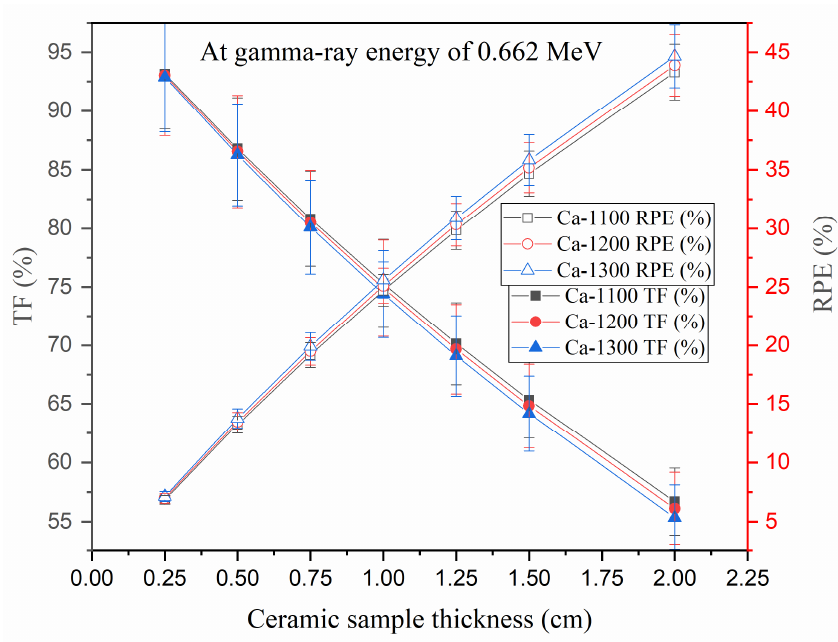
Figure 8. Variation of both TF and RPE versus the thickness of the ceramic sample.